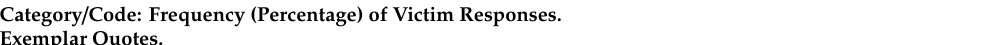
Table 1. Content analysis of self-defined gang-stalking victims’ accounts according to their subjective